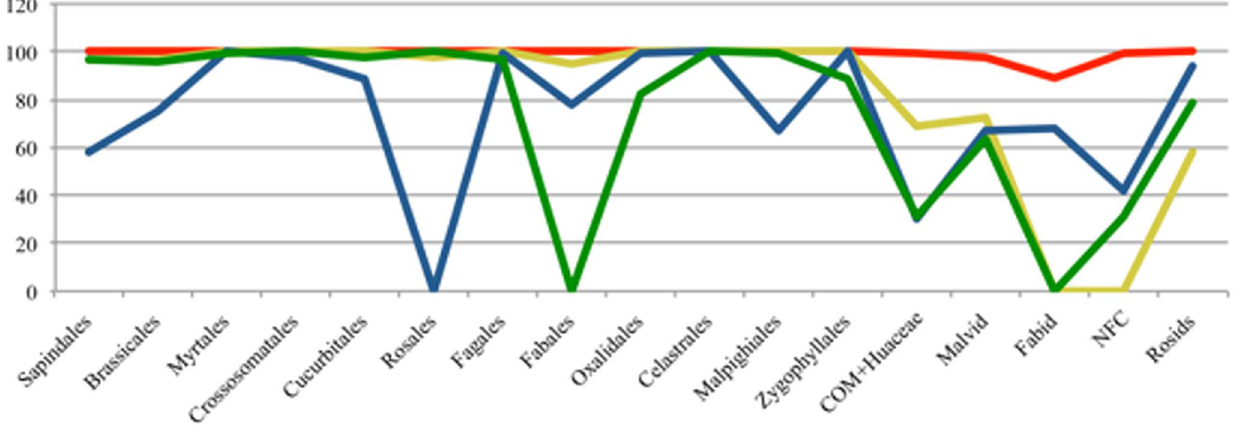
Figure 3. Variation in bootstrap support for the major rosids lineages derived from gene partition analyses. Illustration of the differential bootstrap support for the rosids orders and the major clades calculated from the RAxML analyses based on partitioned gene data sets of matK (red), matR (yellow), rbcL (blue), and atpB (green).